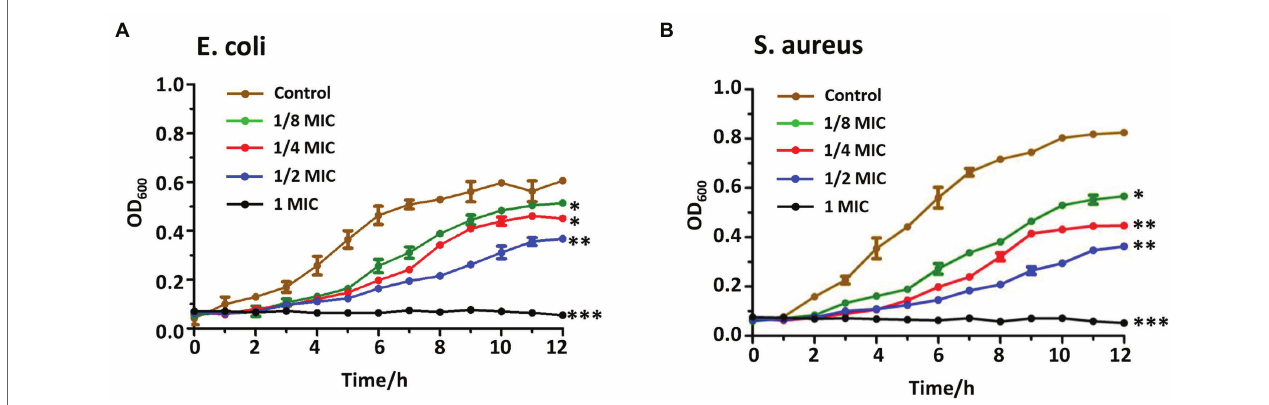
FIGURE 3 | Bactericidal kinetics of PcG 3 K 5 (RW) 3 . The bacterial growth of Escherichia coli (A) and Staphylococcus aureus (B) were slowed down in the presence of different concentrations at the concentration of PcG 3 K 5 (RW) 3 at 1/8, 1/4, 1/2, 1-fold of minimum inhibitory concentration (MIC). Each experiment was performed in triplicate. *, **, and *** indicate significant differences ( p < 0.05, p < 0.01, and p < 0.001) from the corresponding control